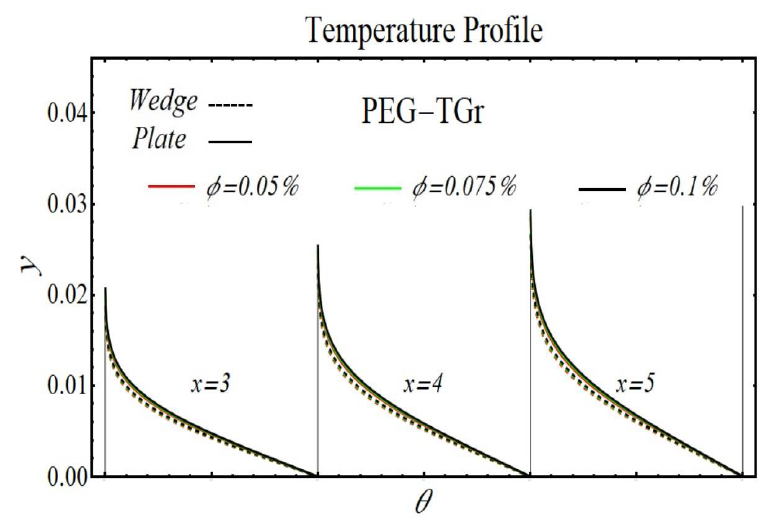
Figure 26. The temperature profile of PEG-TGr/DIW nanofluids over the wedge and plate under the impact of nanoparticle volume fraction.